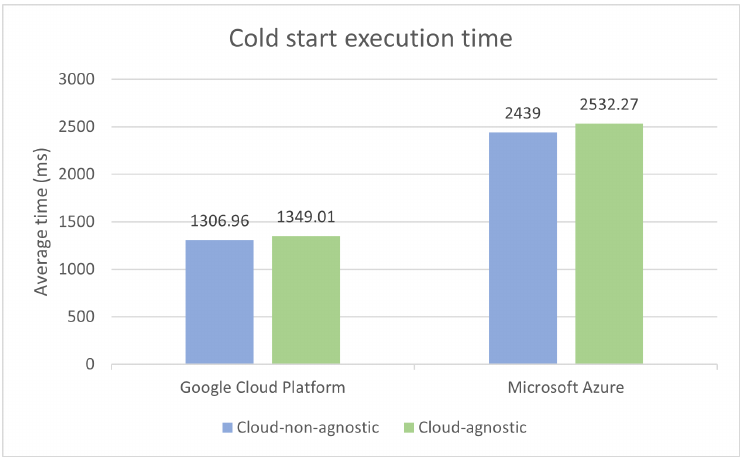
Figure 13. Cold start execution